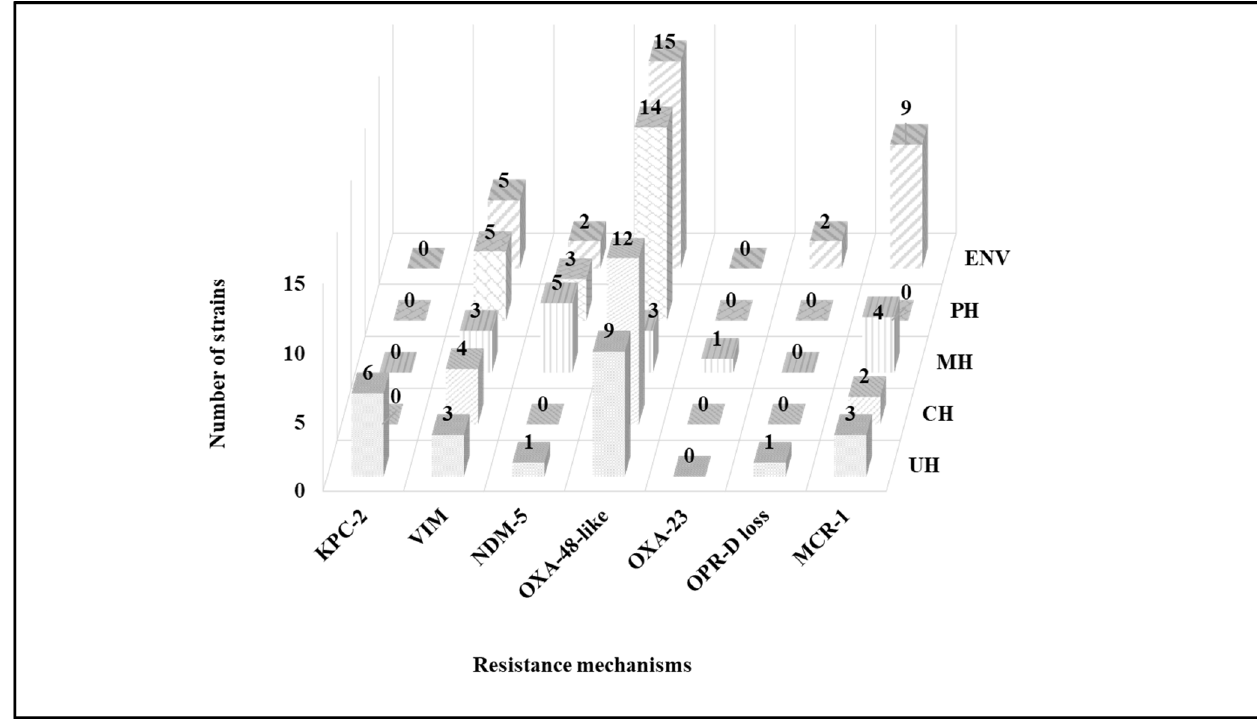
Figure 2. Detected β -lactam and colistin resistance mechanisms in wastewater by sampling site. CH, cancer hospital; ENV, environment; MH, maternity hospital; PH, public hospital; UH, university hospital.